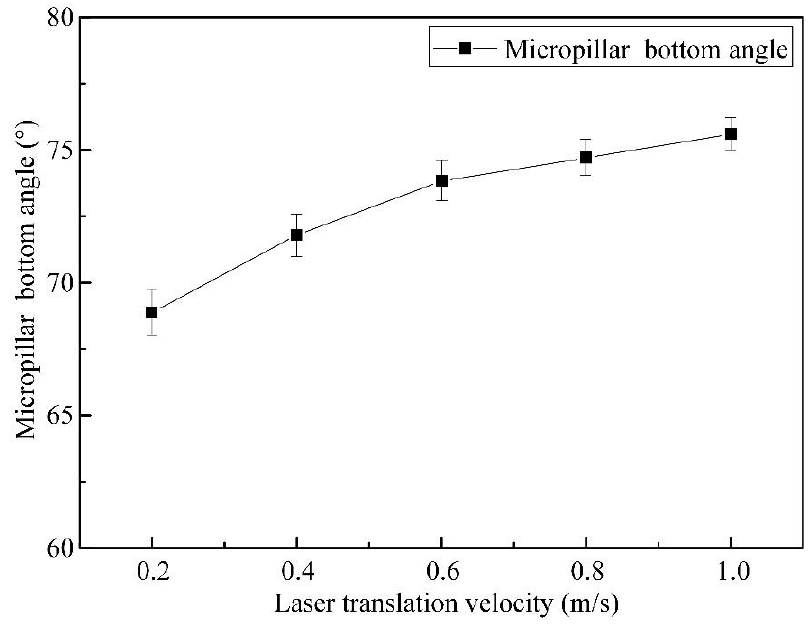
Figure 11. Influence of laser translation velocities on the bottom angle of micropillars, with a pulse energy of 50 μJ and a pulsed repetition rate of 600 kHz.